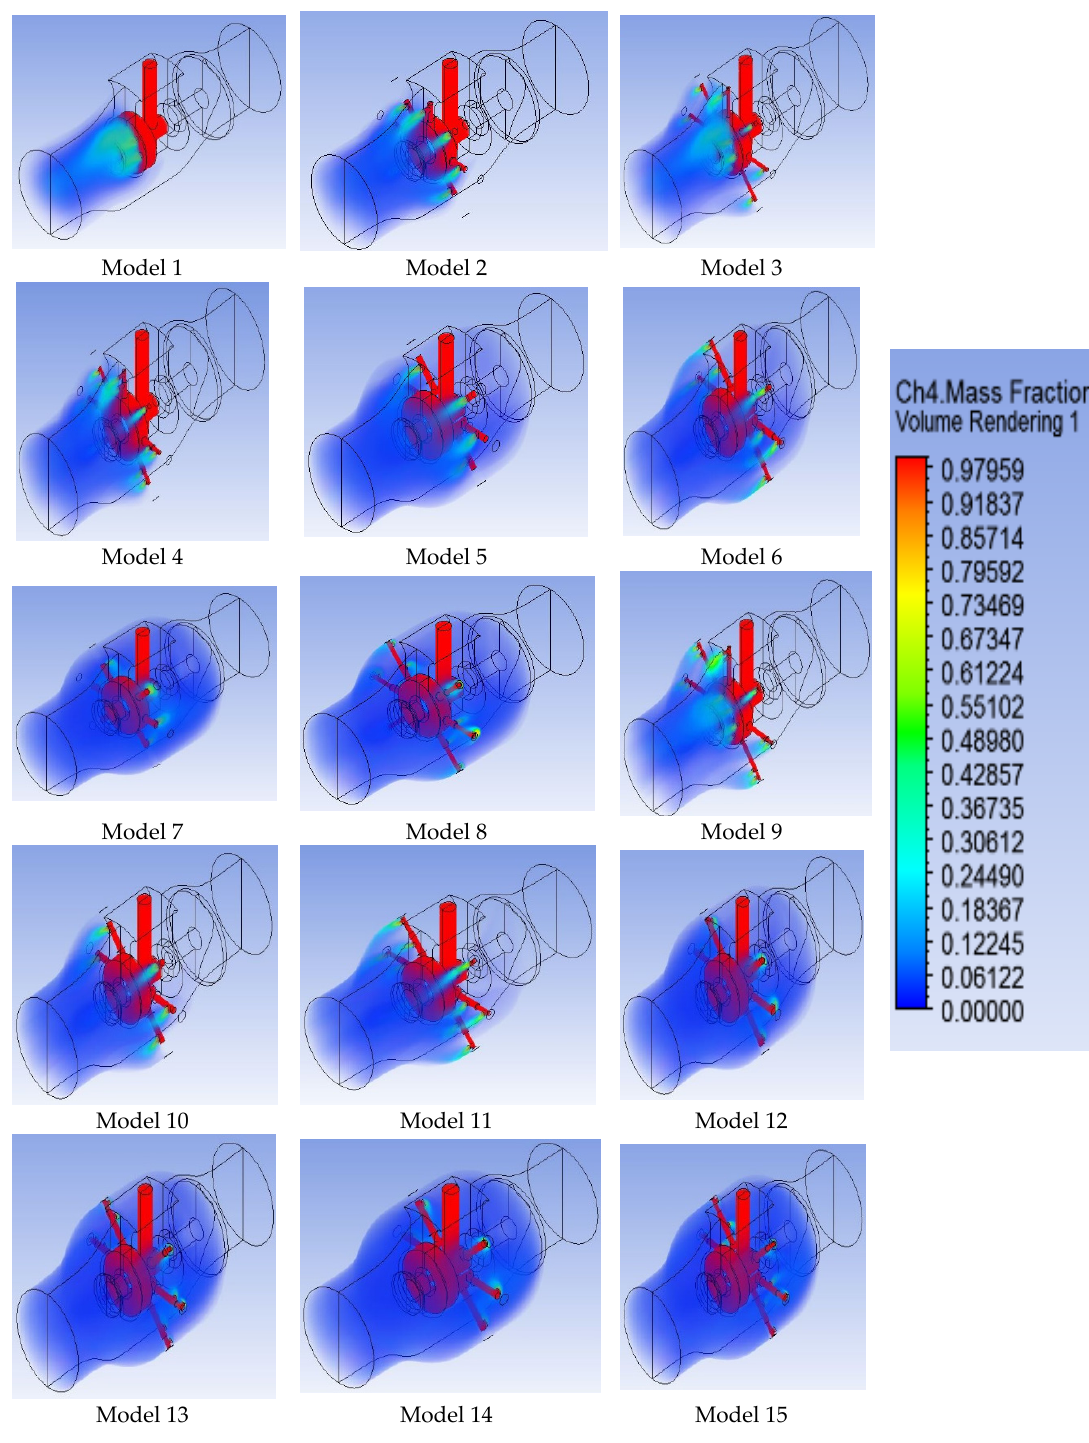
Figure 12. Volume rendering for methane mass fraction of the existing mixer and new mixer models (best case for each model) under air-CNG ratio 34.15.